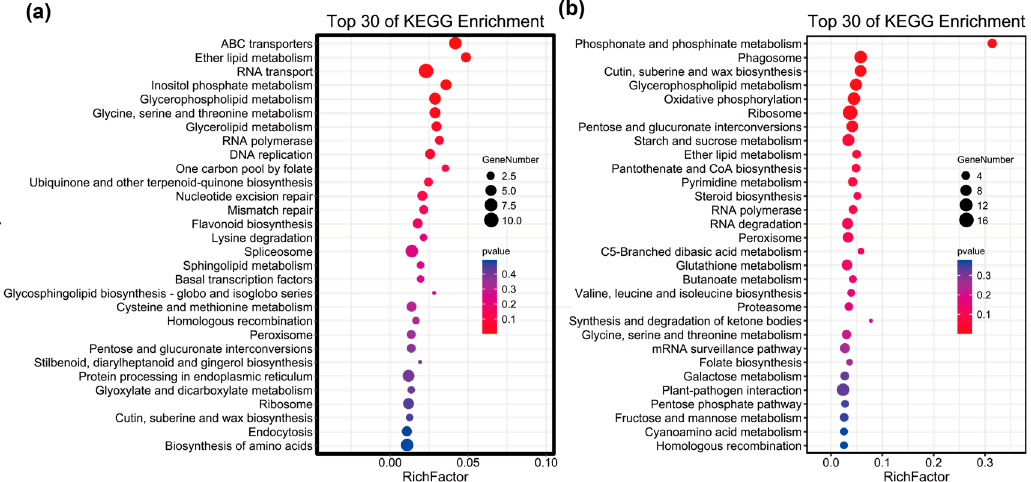
Figure 6. KEGG enrichment analysis of selected genes. The color scale indicates the p value: ( a ) MKS population; ( b ) WYL population.